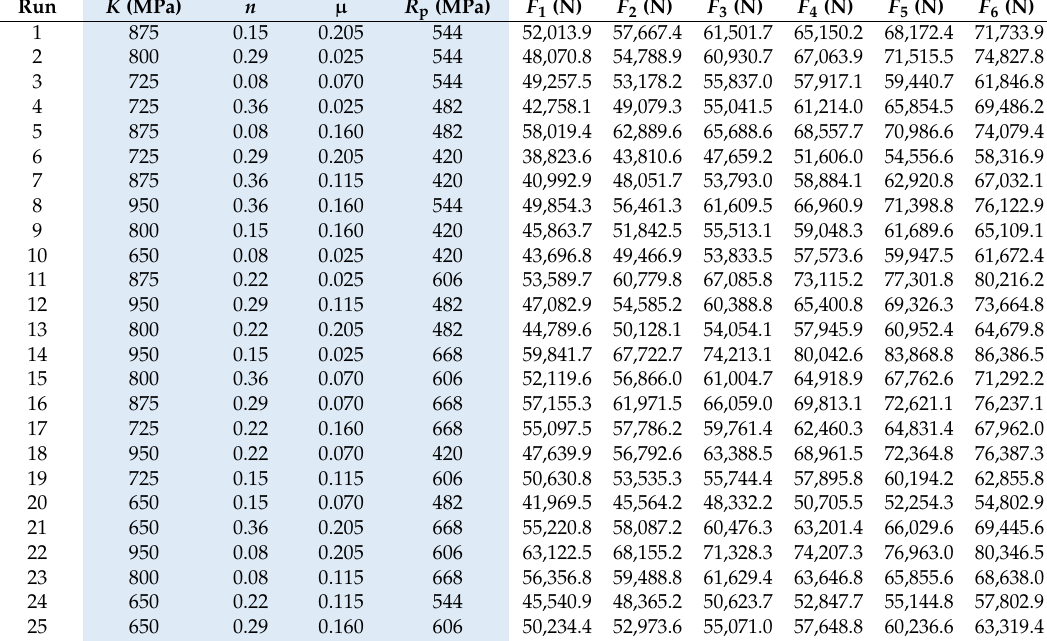
Table 4. FEM-obtained results of forming forces at six observed upsetting